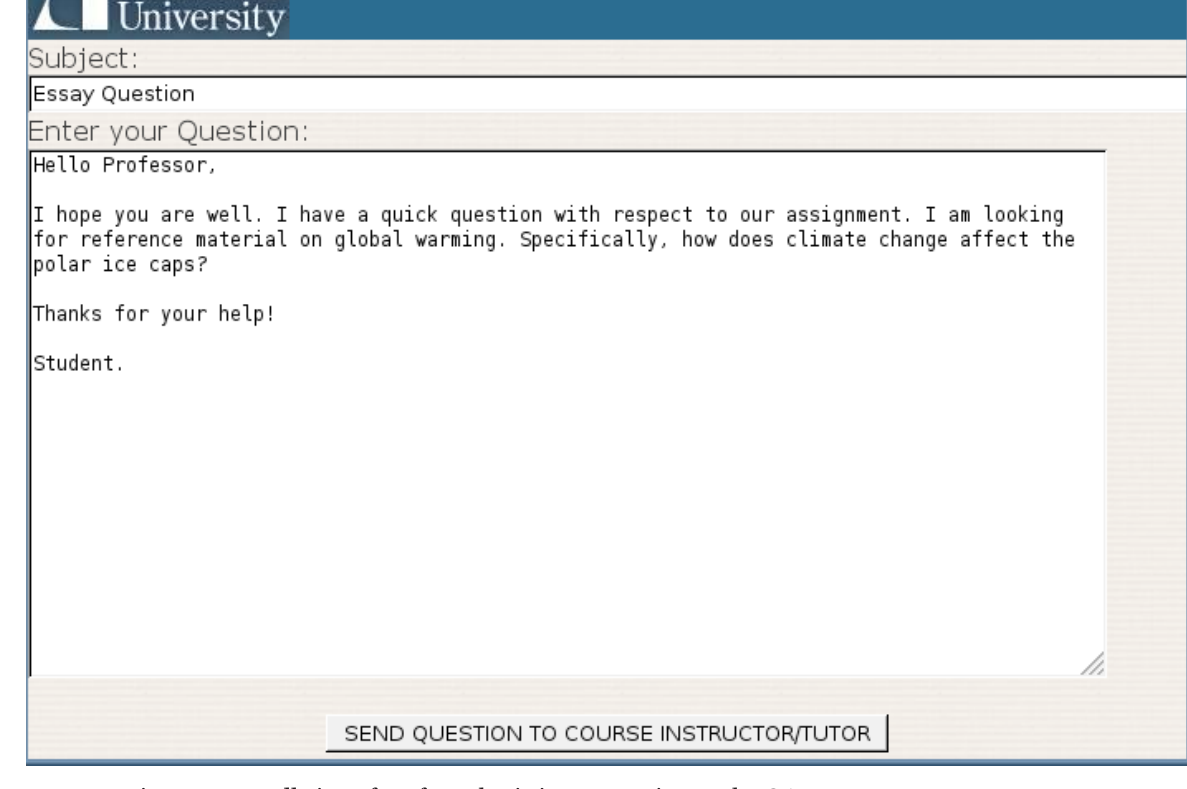
Figure 4 . Moodle interface for submitting a question to the QA